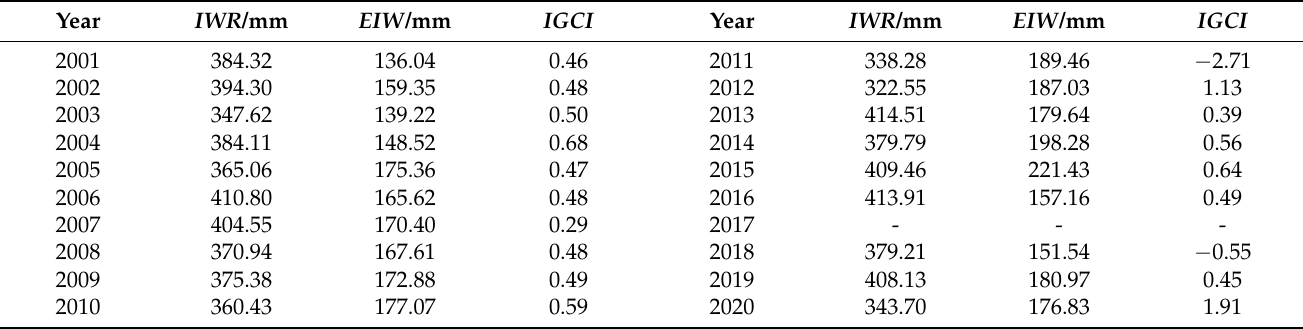
Table 2. IWR , EIW , and IGCI from 2001 to